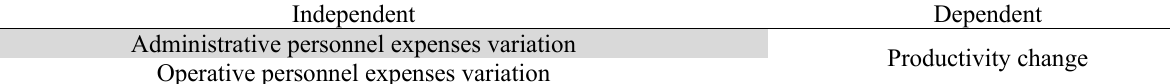
Productivity change